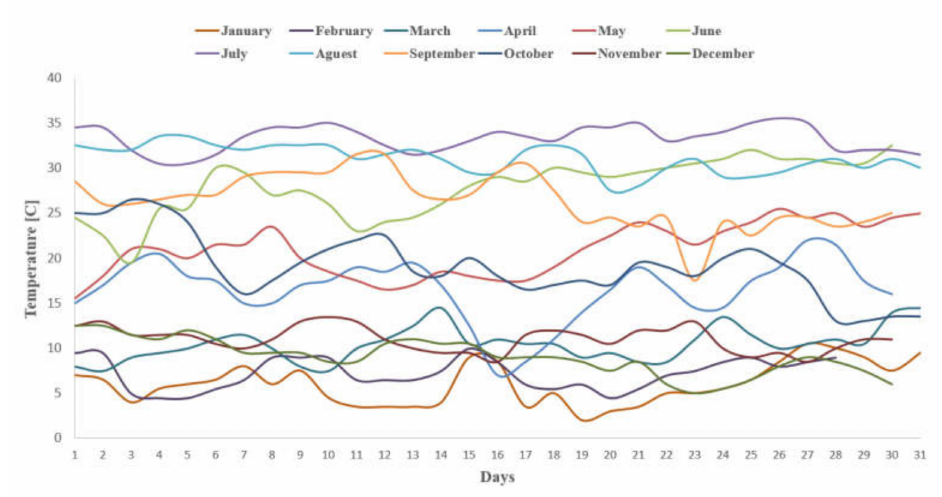
Figure 5. Average values of daily temperature changes in different months of the year.